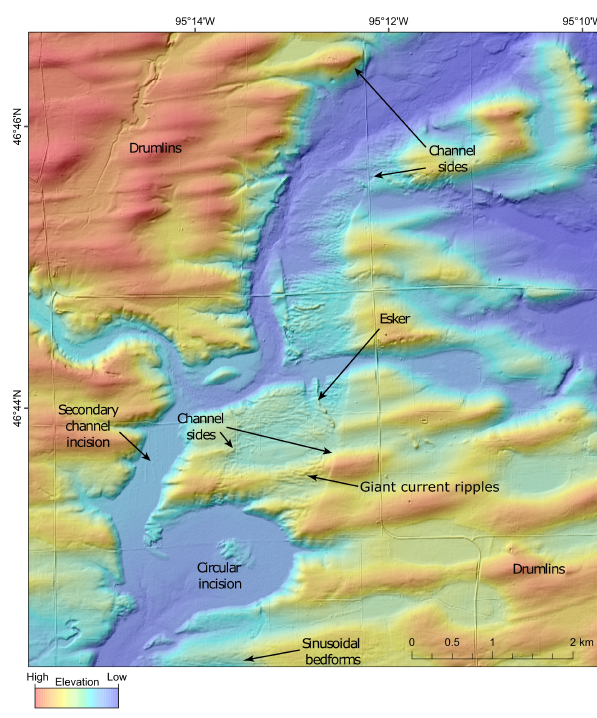
Figure 13. Giant Current Ripples spanning the width of a shallow tunnel valley that is cut into an obliquely-oriented drumlin field (wa- ter flow to the south). These sinusoidal bedforms are interpreted as giant current ripples, which formed during a large subglacial flood. Note the undulating thalwegs and esker in the valley that indicates subglacial deposition, and the circular incision (with a remnant is- land in its centre) in the south of the valley that may have been formed by a large eddy during high-energy turbulent